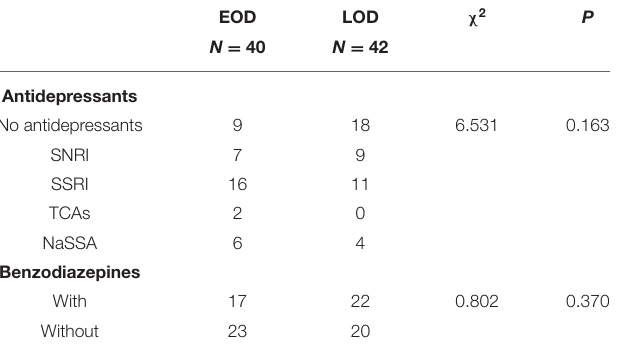
TABLE 2 | The comparison of medication information between EOD and LOD.